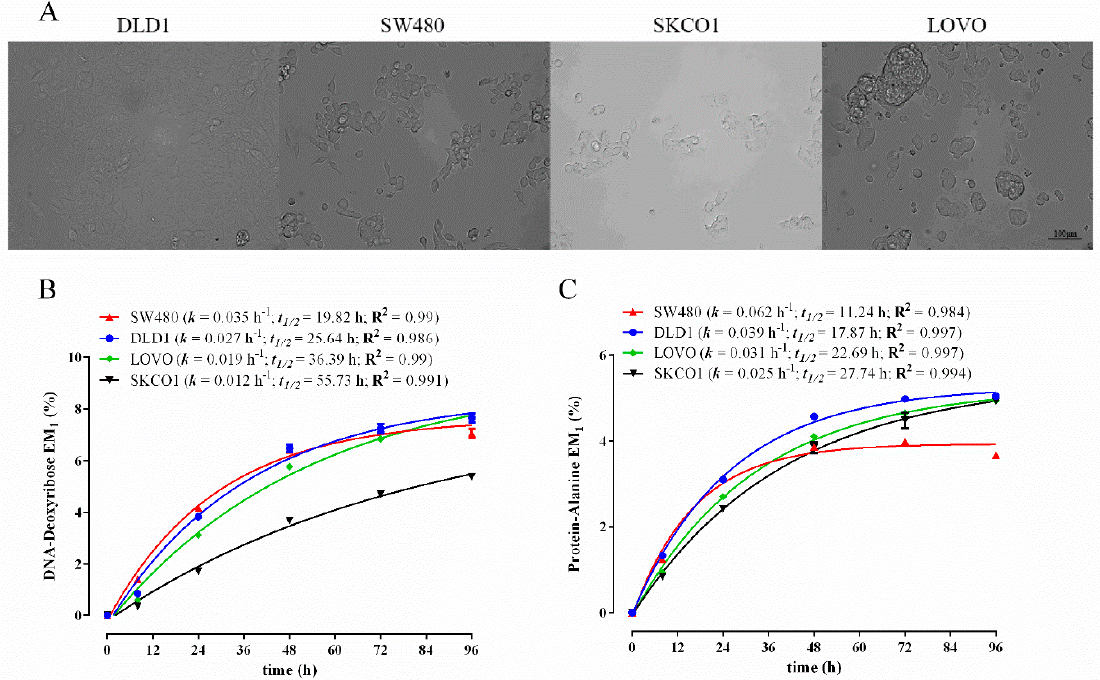
Figure 5. Comparison of 2 H-incorporation into DNA-bound deoxyribose and protein-derived alanine in colon cancer cell lines following incubation in the presence of 5% 2 H 2 O over 96 h. Representative images of colon cancer cell lines ( A ). Excess molar enrichment in the M 1 isotopomer (EM 1 ) over time in DNA-derived deoxyribose ( B ) and protein-derived alanine ( C ) in human colon cancer cell lines grown under identical conditions. Inset: fractional synthesis rate constant ( k ), half-life ( t 1/2 ) and goodness-of-fit (R 2 ) from non-linear curve fitting. Three replicates were performed for each time point. Error bars represent the standard error of the mean (SEM).